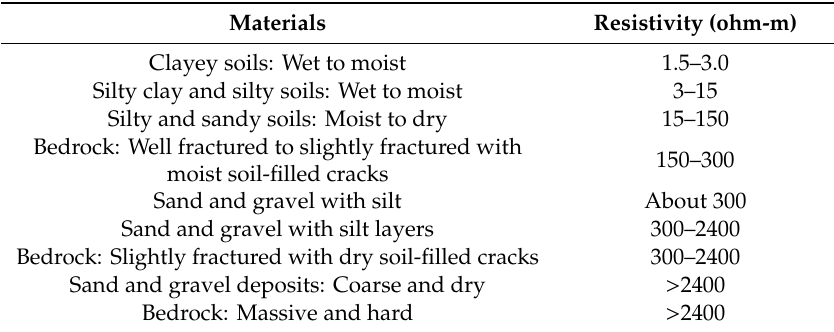
Table 3. ER values of the different soil types.